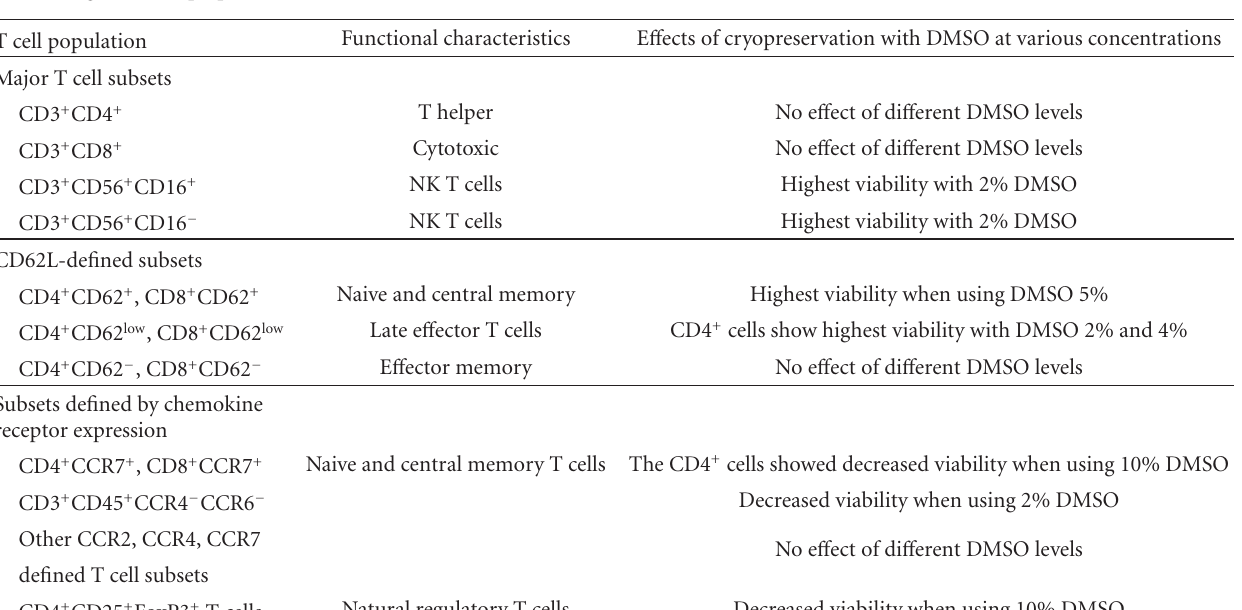
Table 1: Cryopreservation of autologous peripheral blood stem cell grafts in cancer patients; a summary of the e ff ects on immunocompetent cells when grafts were prepared with 2%, 4%, 5%, and 10% DMSO.